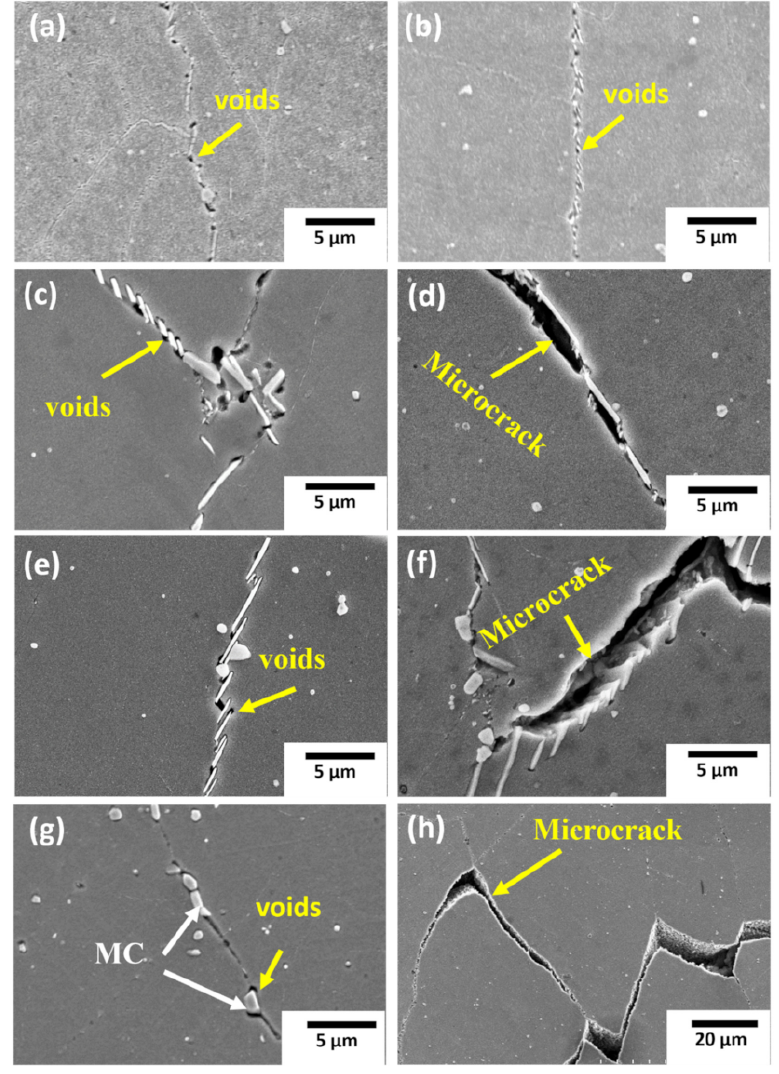
Figure 11. SEM micrographs of cross-sections of crept specimens showing voids and microcracks at grain boundary δ precipitates of ( a ) AB, ( b ) DA, ( c , d ) SA, and ( e , f ) HSA, and at grain boundary carbides of ( g , h )